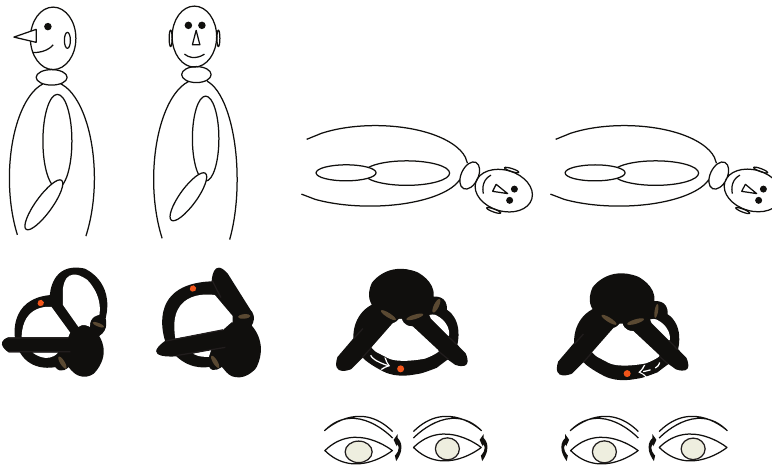
Figure 2: The mechanism of spontaneous inversion of nystagmus in a patient with left-sided PC-BPPV (dark arrow indicates the direction of the